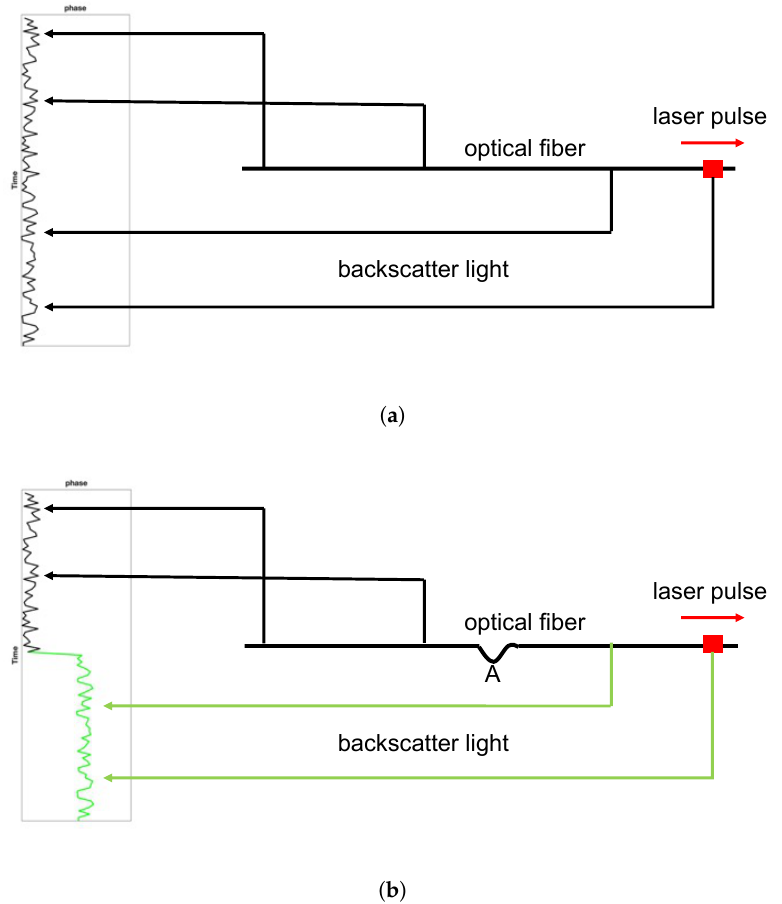
Figure 1. DAS schematic. ( a ) The situation of no disturbance occurring. ( b ) The situation with disturbance occurring on the fiber. The green color stands for the changed light paths and